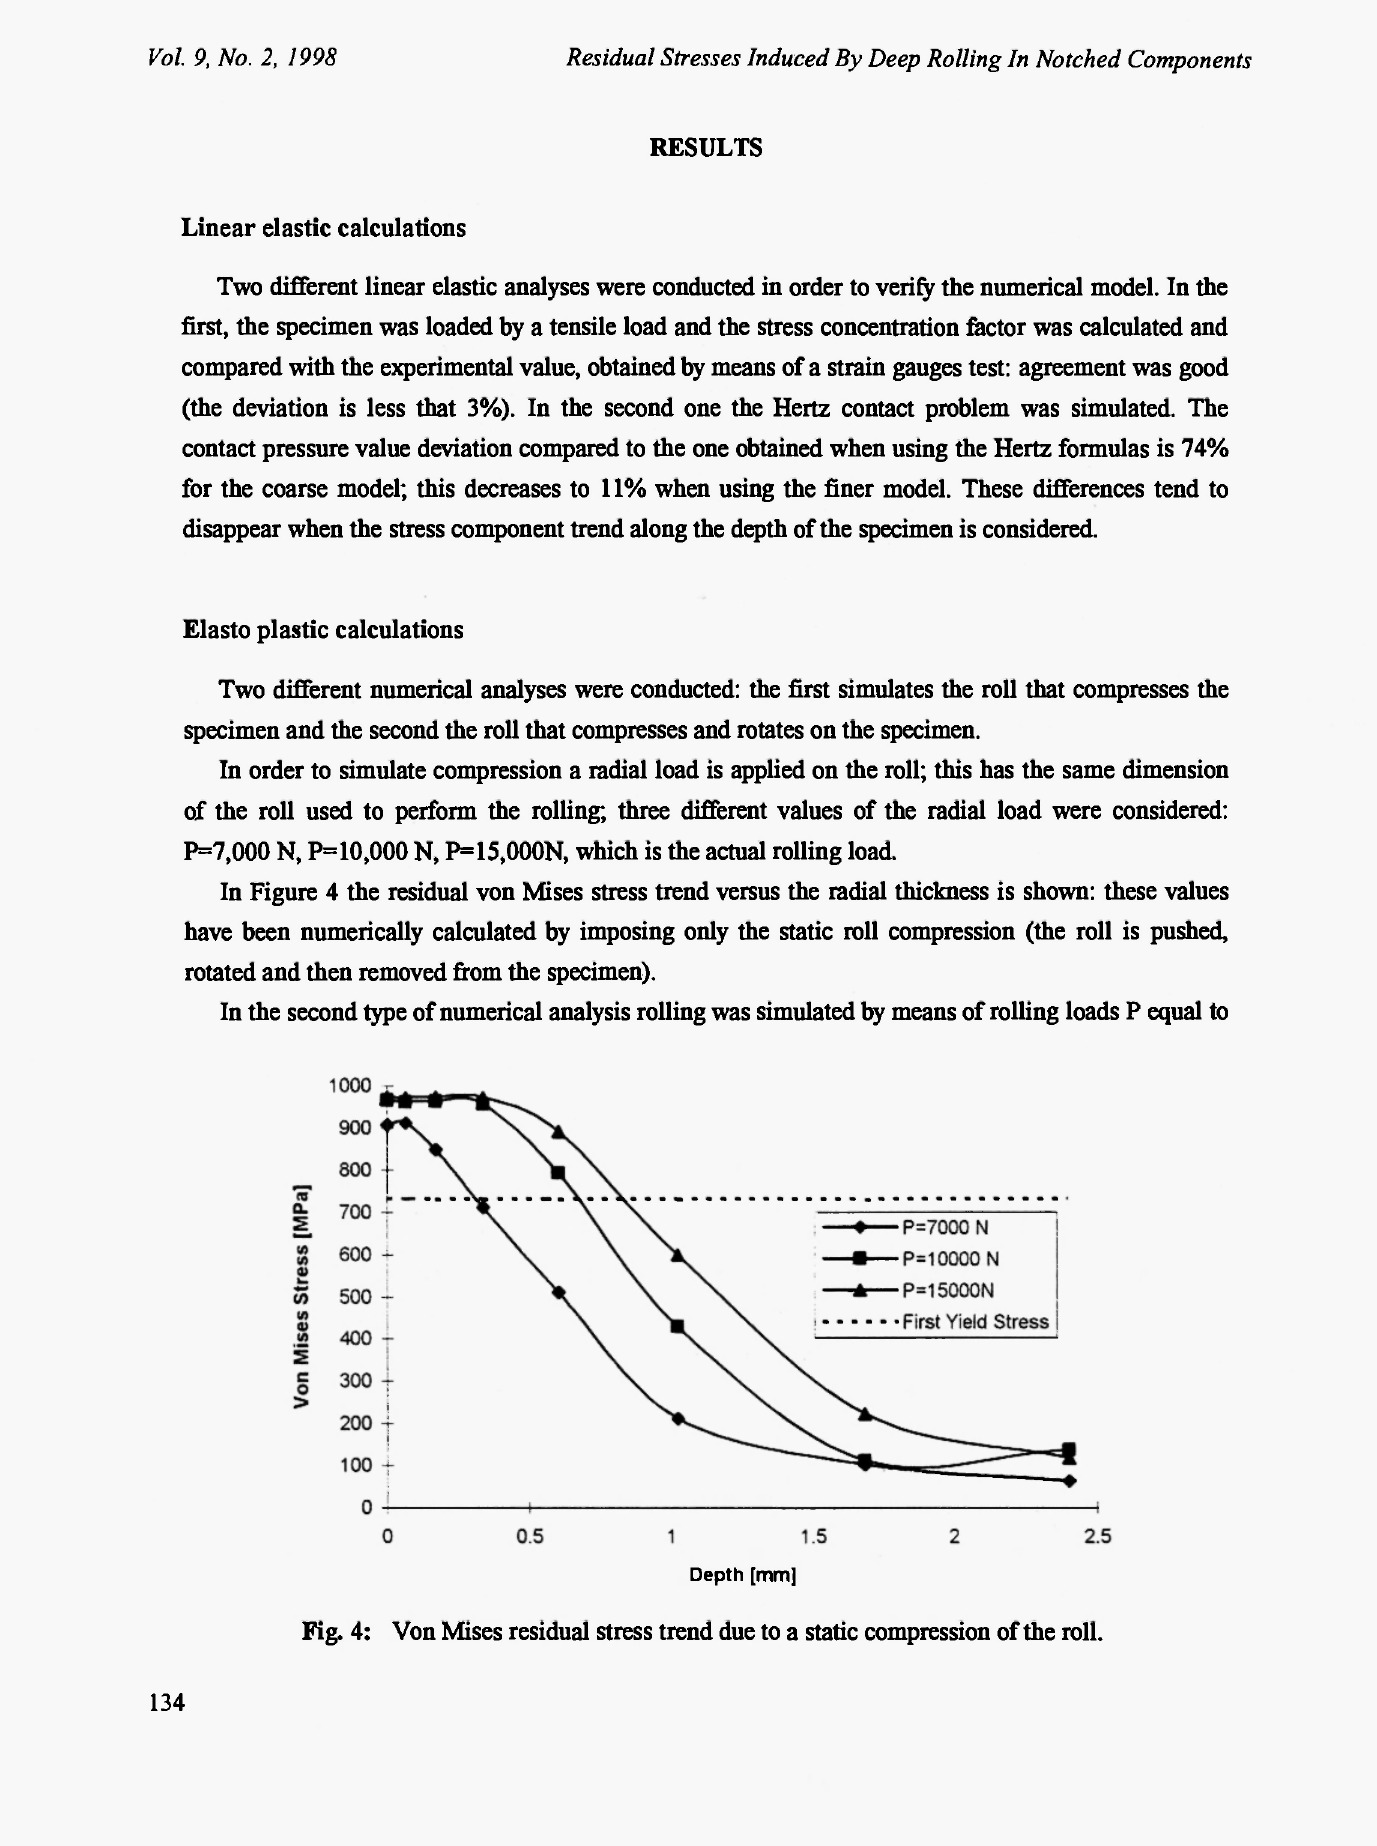
Fig. 4: Von Mises residual stress trend due to a static compression of the